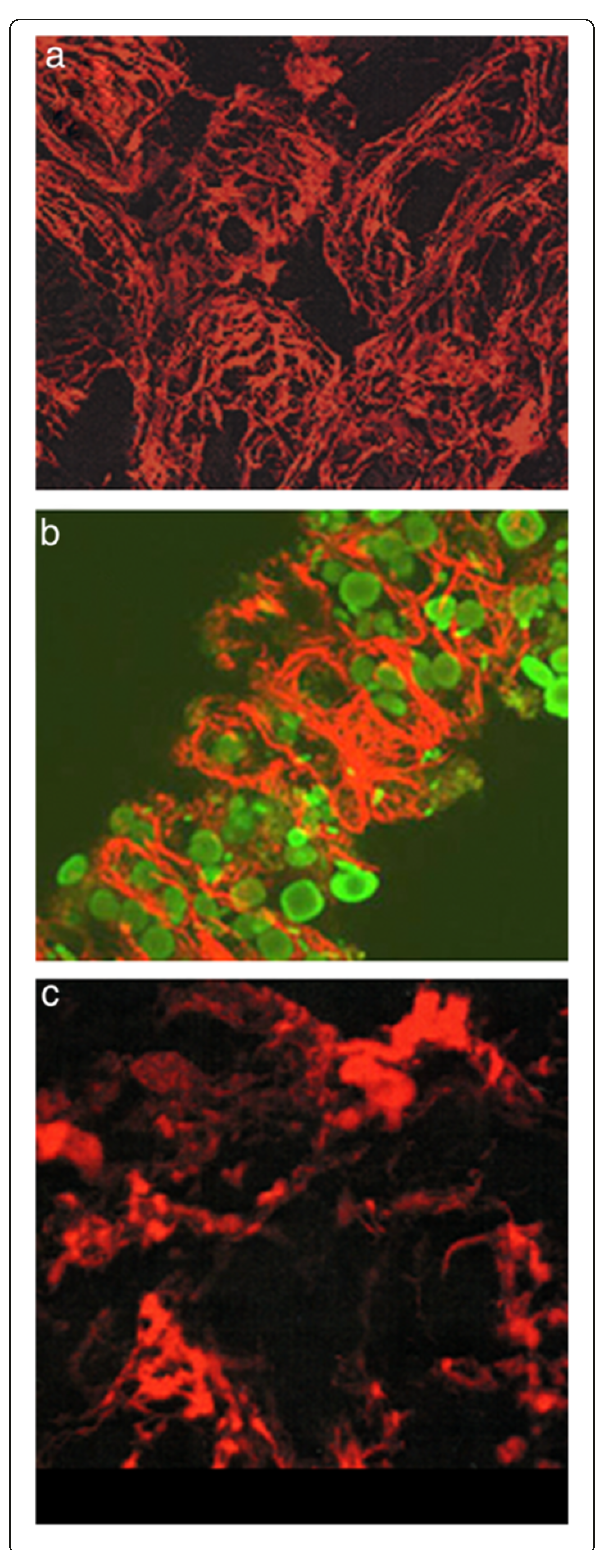
Figure 4 Transfection of isoform-specific sense and anti-sense oligonucleotides in the ventricle of normal hearts. a. Confocal microscopy of normal axolotl hearts transfected with TPM1a anti-sense oligonucleoted and subsequently stained with CH1 monoclonal antibody. TPM1a anti-sense oligonucleotide did not result in a drastic disruption of organized myofibrils in the ventricle, which is comparable with the normal untreated control hearts (figure not shown). Sarcomeric TM can be seen in most of the cells. Contractility of the anti-sense treated hearts were not affected. b. TPM1 κ anti-sense transfection disrupted the myofibril organization in normal axolotl heart compared to TPM1 κ sense transfection. Very little organized structure is seen when examined by the tropomyosin staining. The secondary antibody is contained within amorphous areas in the cells. c . It shows that the TPM1 κ sense oligonucleoides did not affect the structure. Since no effect on myofibril structure with TPM1 κ sense was observed, we tagged the oligonucleotide with FITC (green) to verify its presence and found it to be within the myocytes. Double staining of the nucleus (green) and the myofibrils at the periphery of the cells (red) can be seen. The green staining is ovoid in shape and primarily located at the center of the cells [10]. Confocal z-series images of stage ~38 embryonic axolotl hearts transfected with either TPM1 κ anti-sense or sense oligonucleotides. Immunodetection of sarcomeric tropomyosin using CH1 monoclonal antibody is shown in red. The results depicted by this figure suggests that TPM1 κ plays a critical role in maintaining the myofibrillar structure in embryonic axolotl